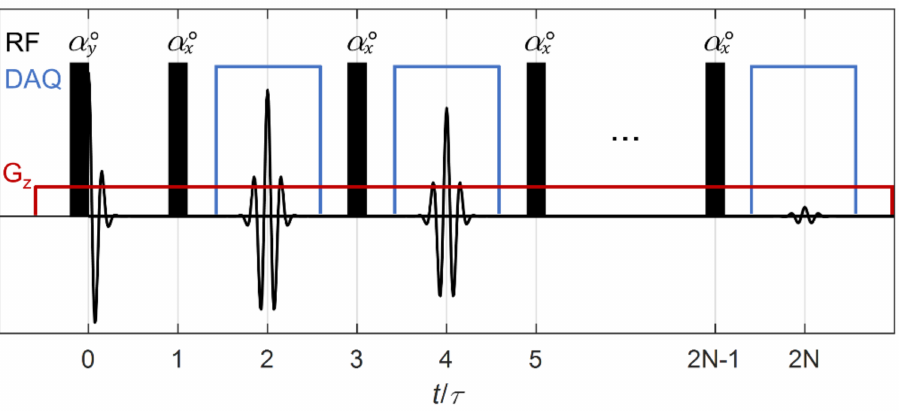
Figure 10. Schematic representation of the broadband excitation constant-gradient LFA-CPMG pulse sequence used in flow experiments. RF pulses with on-resonance flip angle α ◦ are indicated by black rectangles. Digital acquisition (DAQ) of spin-echoes is represented in blue. The field gradient G z is represented in dark